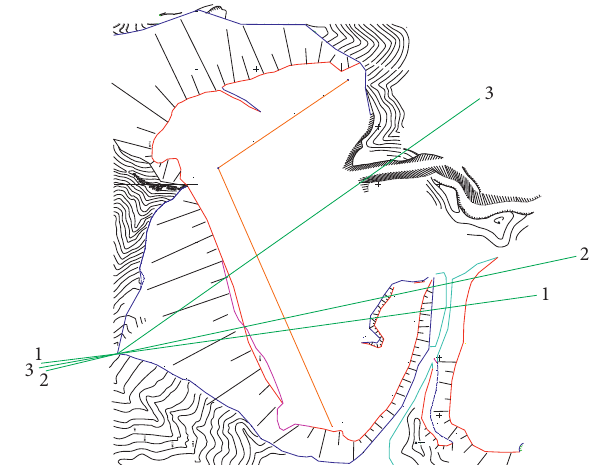
Figure 8: The positions of sections 1-1, 2-2, and 3-3.